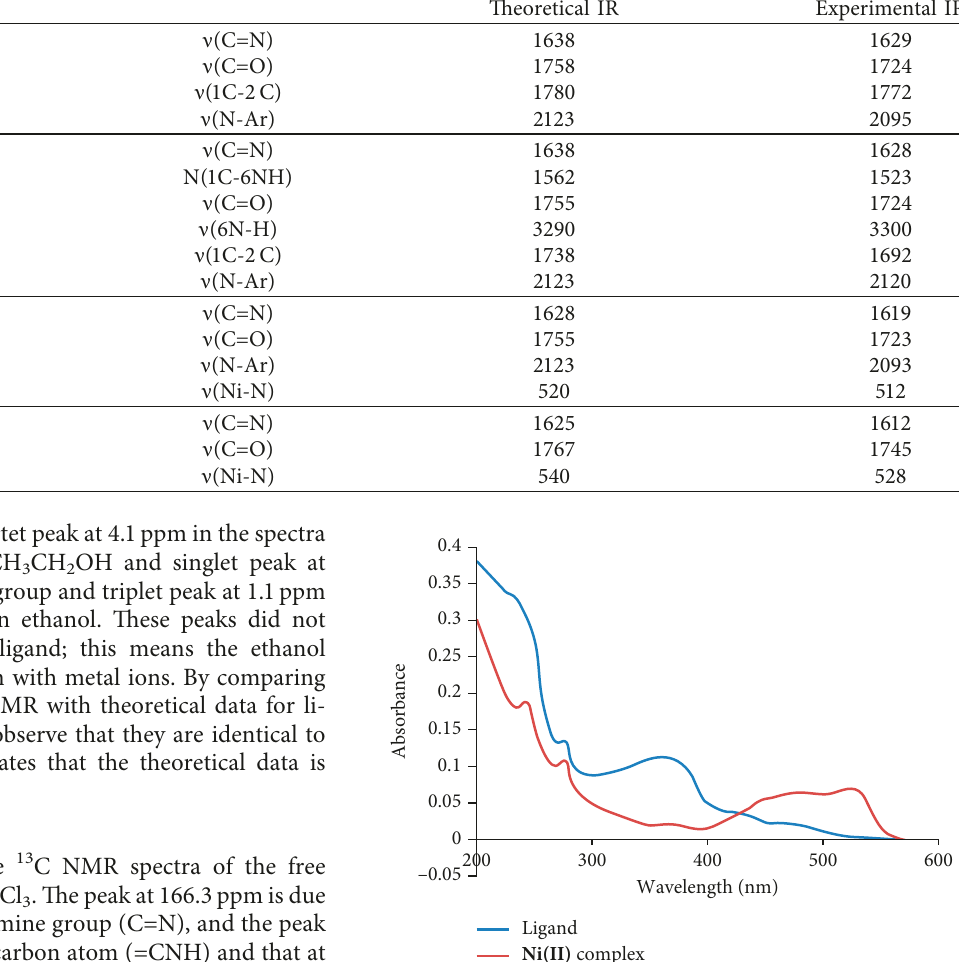
Table 2: Selected IR-vibration values (theoretical and experimental) (cm − 1 ) of 1 – 3 . Compound